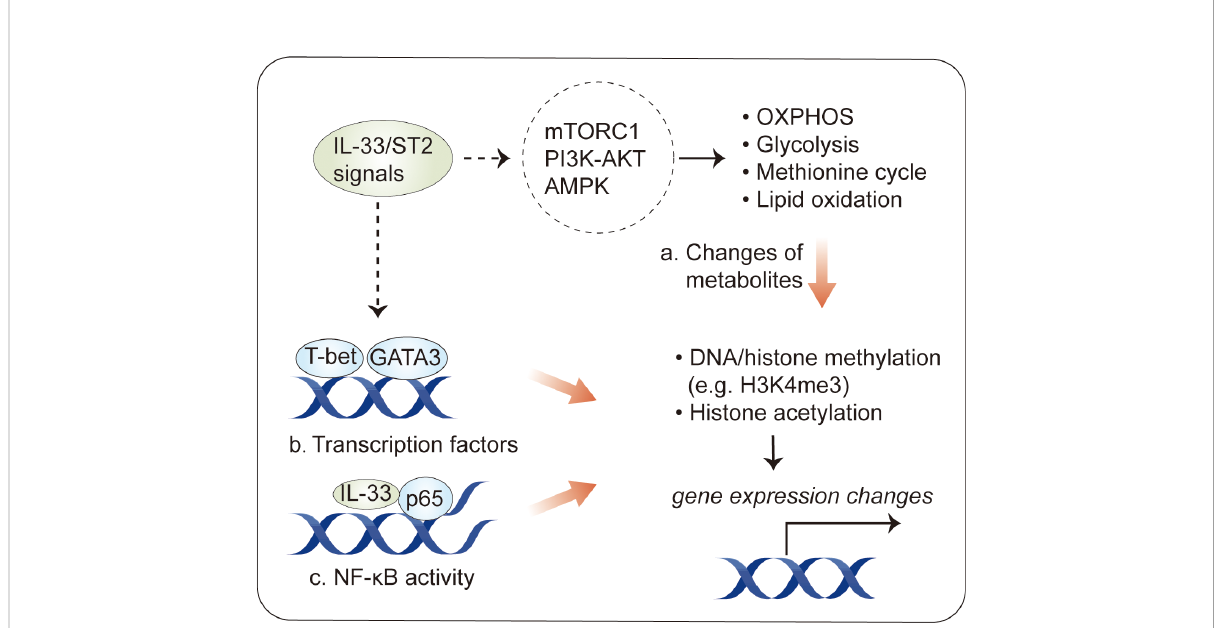
FIGURE 4 Epigenetic modi fi cation in immune cells by IL-33. Epigenetic changes have been described in IL-33-activated immune cells. (A) One consequence of the metabolic changes induced by IL-33 stimulation is an alteration in the production of intermediate metabolites, some of which in fl uence transcriptional activity by the epigenetic regulation of DNA or histones. (B) IL-33 activates transcription factors, such as GATA3 and T-bet, which can induce epigenetic changes at target loci. (C) Intracellular IL-33, as a chromatin-associated nuclear factor, can bind to NF- k B p65 to dampen NF- k B-stimulated gene